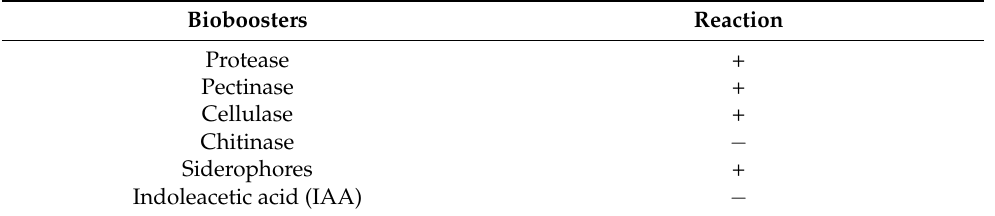
Table 4. Identification of JK-25 growth-promoting